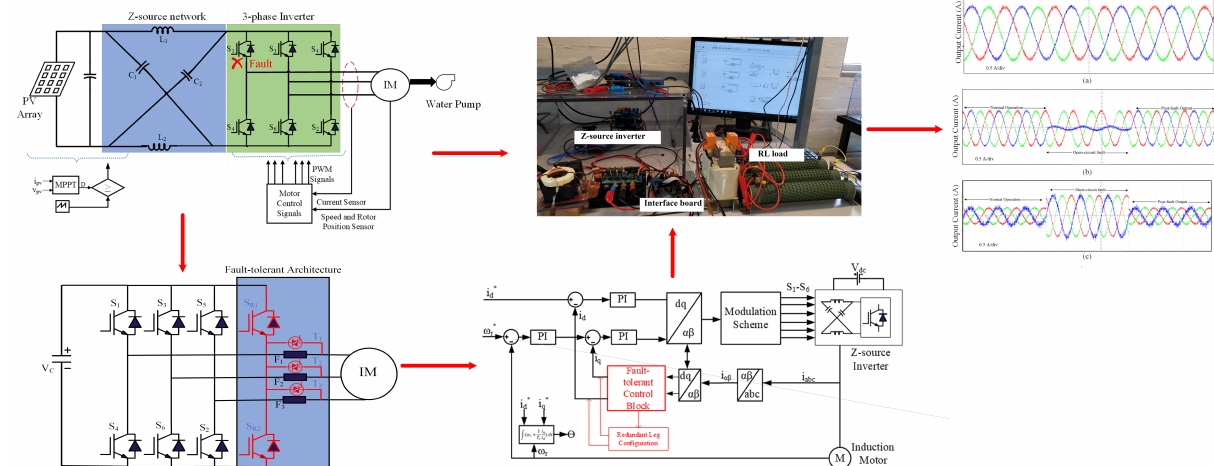
Figure 3. General structure of the scheme proposed in